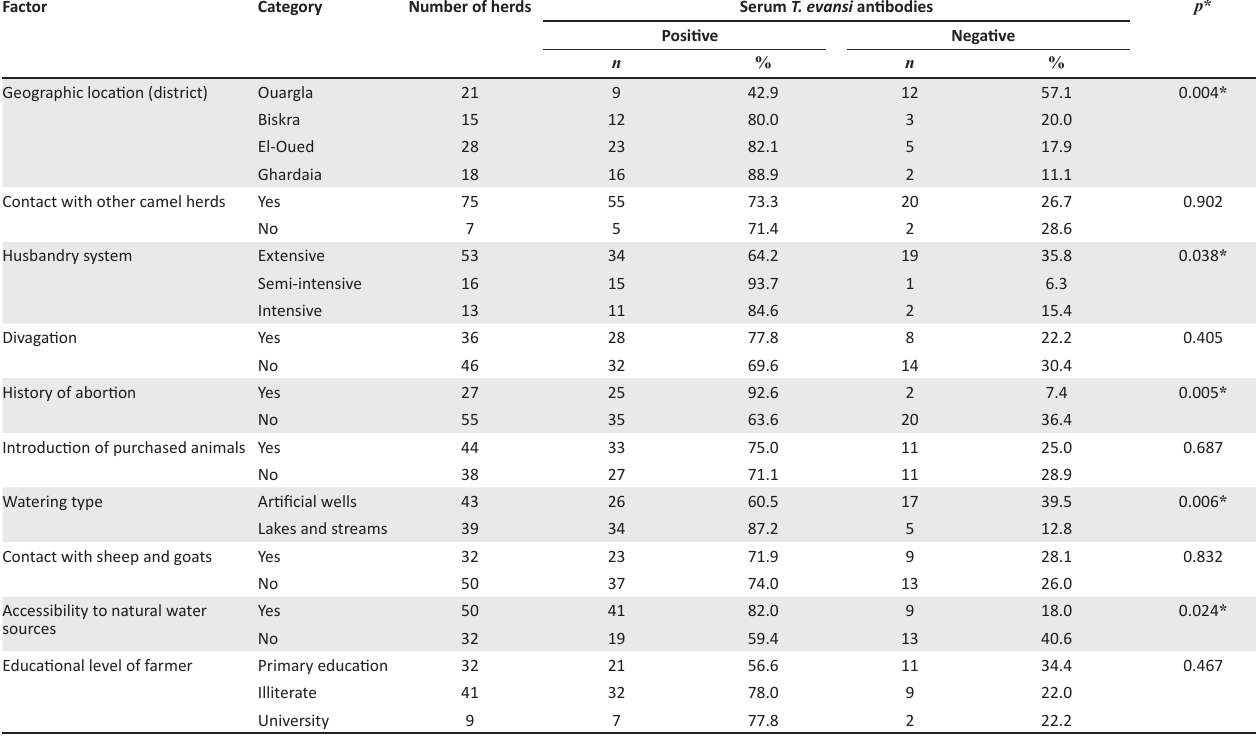
TABLE 3: Factors associated with animal-level seroprevalence of antibodies against Trypanosoma evansi for dromedary camel populations of southeastern Algeria. Factor Category